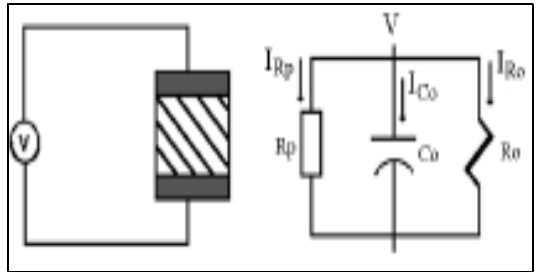
Figura 1: Modelo del aislamiento en DC. Fuente: Autores, (2017).